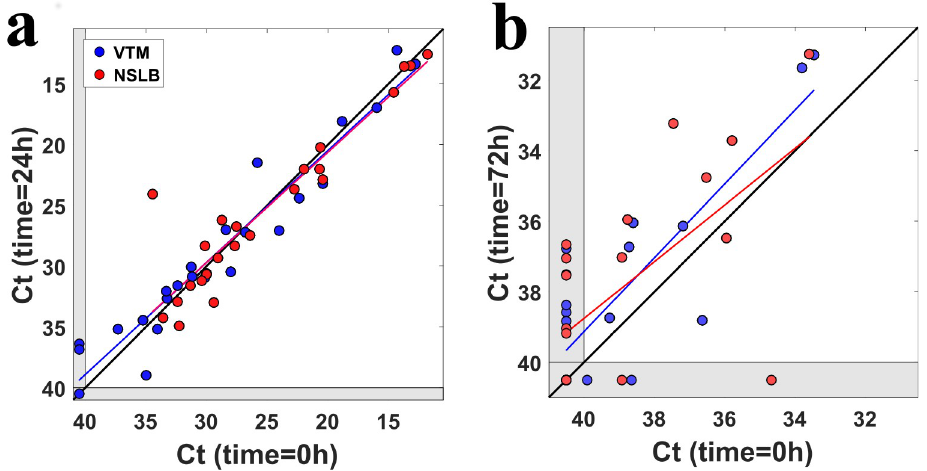
Fig 2. Detection of SARS-CoV-2 RNA at different times of sample storage. (a) Ct values at time = 0h vs. time = 24h for 24 hospitalized patients. Blue dots represent VTM samples and red dots represent NSLB samples. Colored lines are linear fits for VTM and NSLB. (b) Same as (a) but for 20 recovering quarantined patients, tested at times 0h and 72h.